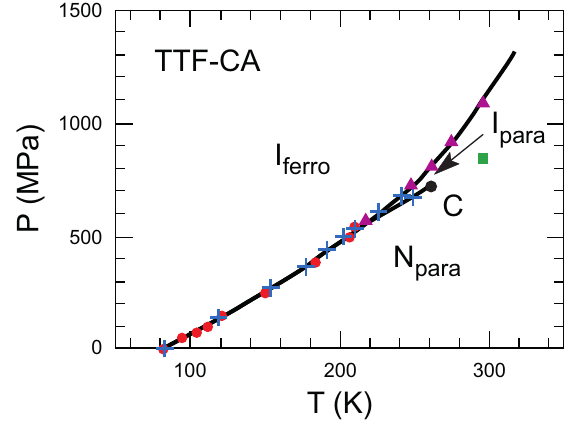
Figure 3. The p - T -phase diagram of TTF-CA exhibits, in a pressure range from 0 to 1500 MPa and in a temperature range from 50 up to 350 K, three different phases (I ferro : ferroelectric ionic phase, I para : paraelectric ionic phase, N: neutral phase). The phase diagram resembles the characteristic of a solid–liquid–gas phase diagram. The red circles refer to neutron scattering and the blue plus signs to NQR results [34]; the violet triangle is obtained by vibrational spectroscopy [21,28,29]; the green square is extracted from transport measurements [11,30]. The black dot around T c = 260 K and a pressure slightly above 700 MPa indicates the critical point labelled by C. Adapted from